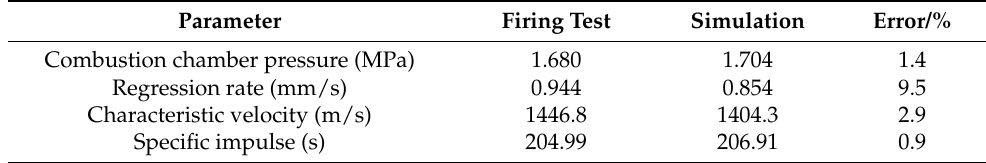
Table 3. Results of firing test and numerical